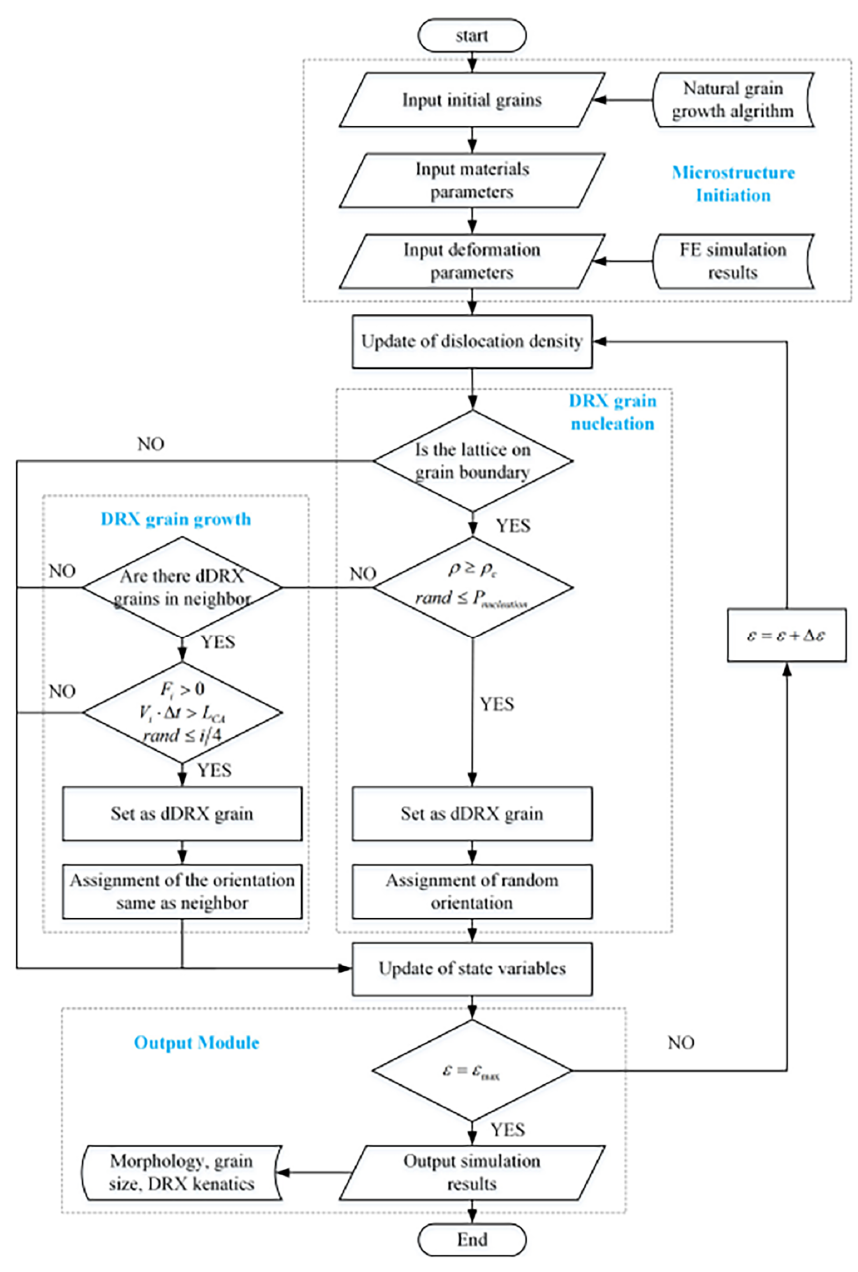
Figure 8. Flowchart of CA simulation.